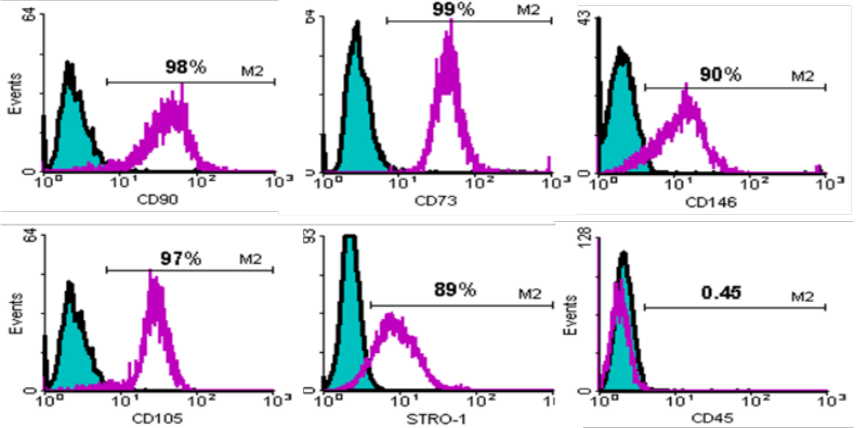
Figure 2. Expression of mesenchymal stem cell markers. Representative histogram of the expression of CD105, CD90, CD73, CD146, STRO-1 and CD45. Green histogram indicates cell fluorescence with control antibody (isotype control) and purple histogram indicates cell fluorescence with the respective antibody.